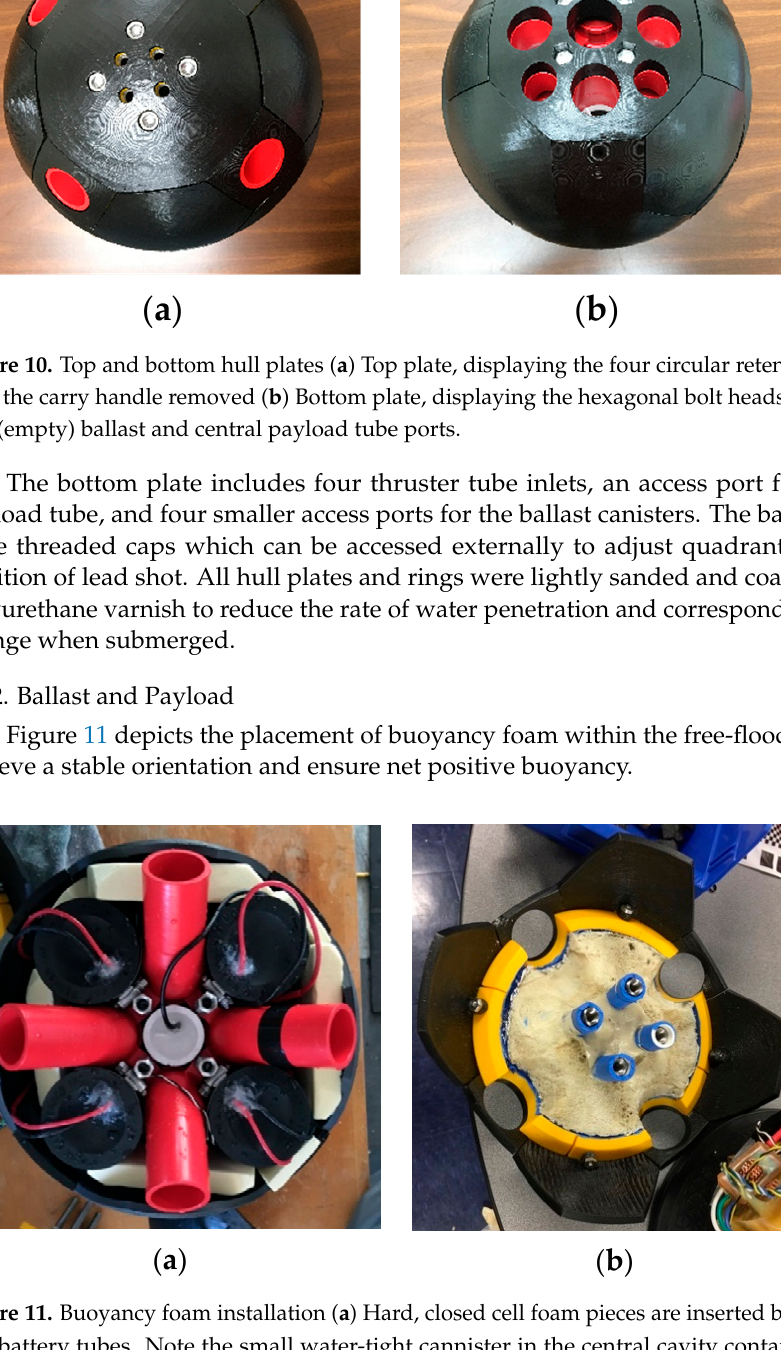
( b ) Figure 9. Hemispheric and plated spherical hulls ( a ) Initial 1/4-scale model and full-scale, hemi- spheric hull prototypes ( b ) Plated hull configuration. The combined print time for both hemispheres exceeded 117 h (at 6 mm thickness, 25% infill) using 1.4 kg of black PLA. Long hemispheric print times, combined with some structural flaws, led to the abandonment of the hemispheric concept and redesign of the hull using the plated-ring scheme described in Section 2.1, as shown in Figure 9b. An ad- ditional fabrication benefit to the plated-ring approach is that multiple plates and reten- tion ring segments can be printed flat (oriented such that the outer surface of the sphere is on top). This resulted in a finer finish when using support material, and enabled the use of smaller printers, which was a design goal. Additionally, all areas of the hull appeared to be stronger when printed as plates than when printed as hemispheres—particularly for the hull sections near the equator. At 20% infill, one of the large equatorial ring plates can be printed in just under 12 h on an Ultimaker 2+. The assembled hull—a truncated cuboctahedron—consists of 26 plates, including eight small hexagons, 12 small squares, and six large octagons arranged on three rings between the upper and lower plates, as shown assembled in Figure 9b. The individual plates are connected to three yellow plate retention rings by stainless steel fasteners. The lower plate ring is similar to the upper plate ring, except that it does not contain thruster outlets. The equatorial ring contains larger plates, which may be exchanged for plates spe-